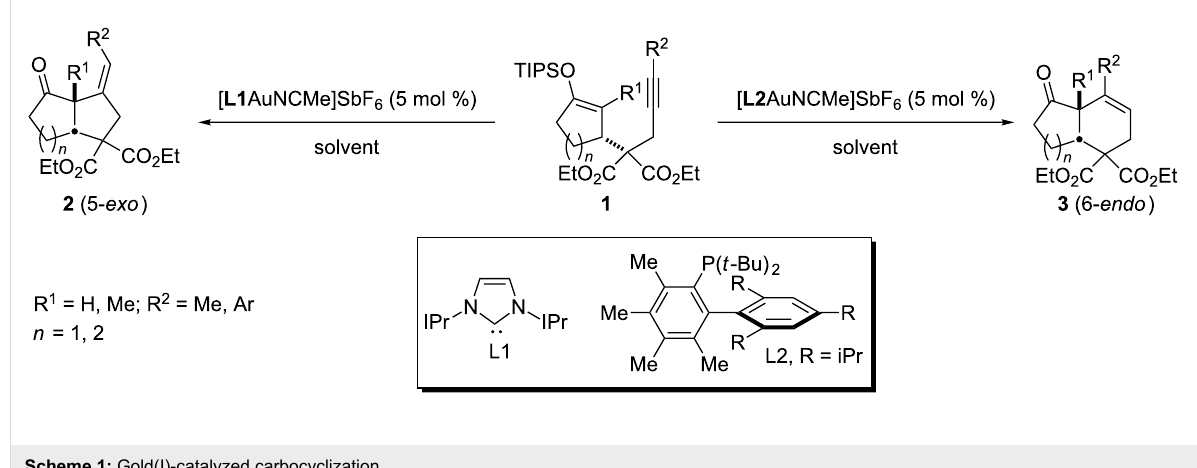
Scheme 1: Gold(I)-catalyzed carbocyclization.